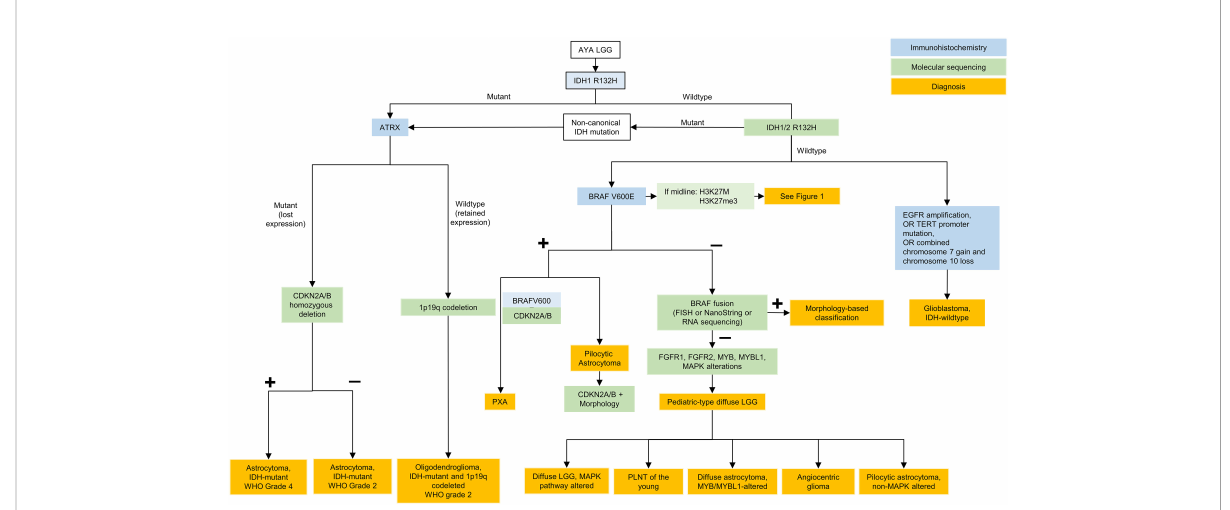
FIGURE 2 Testing algorithm for adolescent and young adult low grade gliomas. AYA, adolescent and young adults; LGG, low grade glioma; IDH, isocitrate dehydrogenase; ATRX, ATRX chromatin remodeler; CDKN, cyclin-dependent kinase inhibitor; WHO, World Health Organization; BRAF, B-Raf; FISH, fl uorescence in situ hybridization; FGFR, fi broblast growth factor receptor; MYB, avian myelobalstosis viral oncogene; MYBL1, MYB Proto- Oncogene Like 1; MAPK, mitogen-activated protein kinase; PLGNT, pediatric low-grade neuroepithelial tumor; PXA, pleomorphic xanthoastrocytoma; EGFR, epidermal growth factor receptor; TERT, telomerase reverse